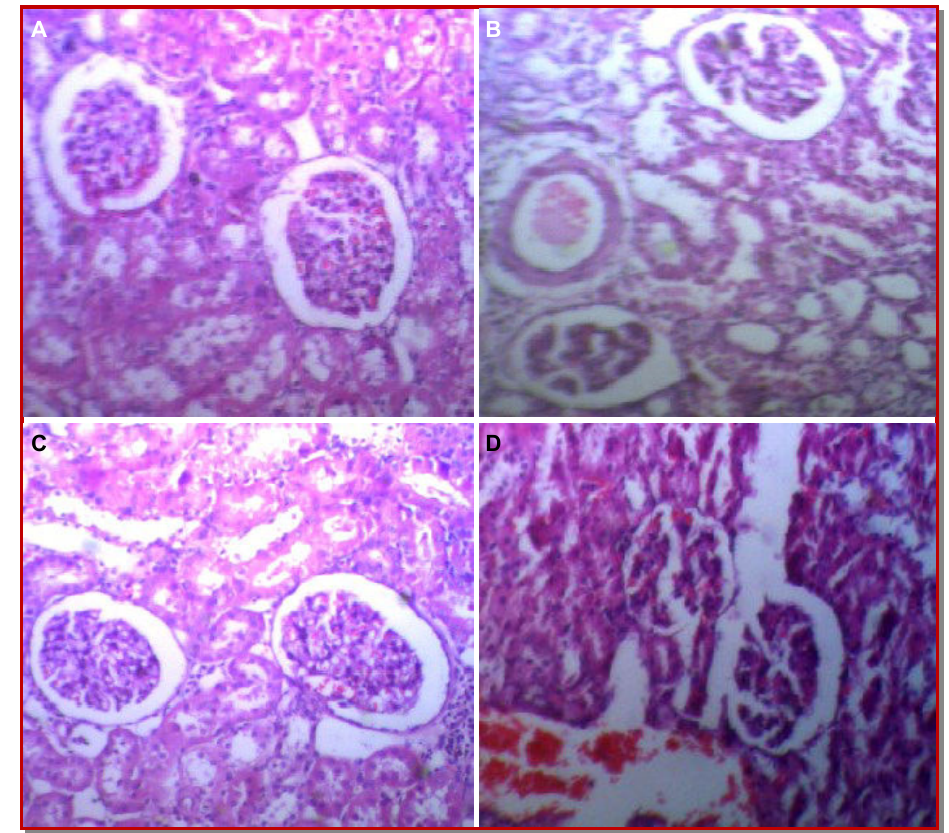
Figure 2: Effect of aqueous extract of leaves of Sechium edule on potassium dichromate-induced nephrotoxicity in rats A: Normal control; B: Treated with potassium dichromate (15 mg/kg, s.c.); C: Treated with Sechium edule (200 mg/kg) and gentamicin (100 mg/kg, i.p.); D: Treated with Sechium edule (100 mg/kg) and potassium dichromate (15 mg/kg,